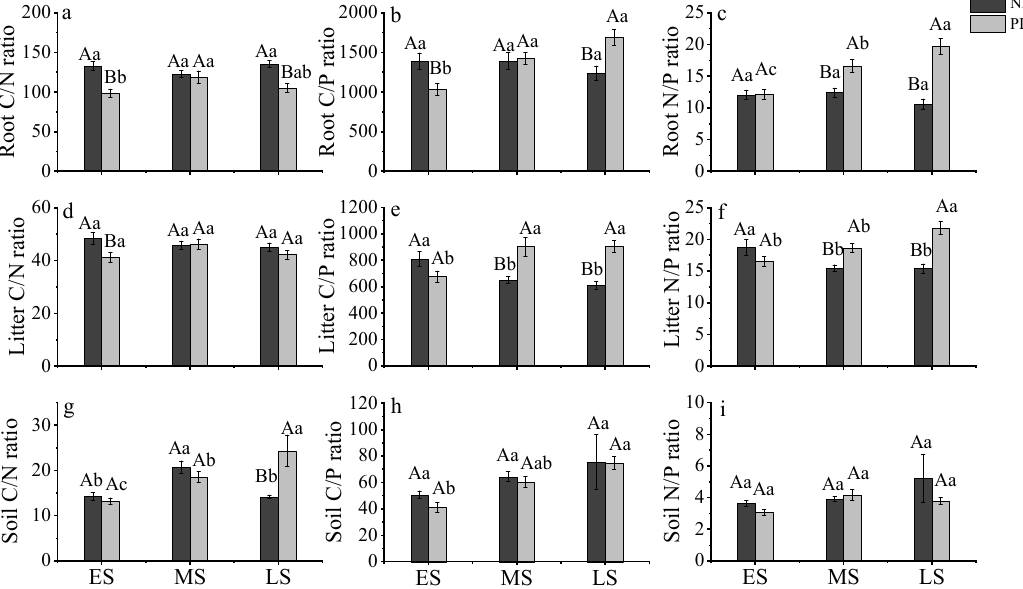
Figure 3. C, N and P stoichiometry in roots ( a – c ), litter ( d – f ) and soil ( g – i ) in different succession stages in NF and PL. Note: The error bars indicate standard errors of the means. Capital letters indicate significant differences in concentrations in different forest origins in the same succession stage ( p < 0.05), while lowercase letters indicate significant differences in concentrations in the same forest origin at different succession stages ( p < 0.05); n = 149, 344, 174, 102, 199 and 144 for NF − ES, NF − MS, NF − LS, PL − ES, PL − MS and PL − LS,